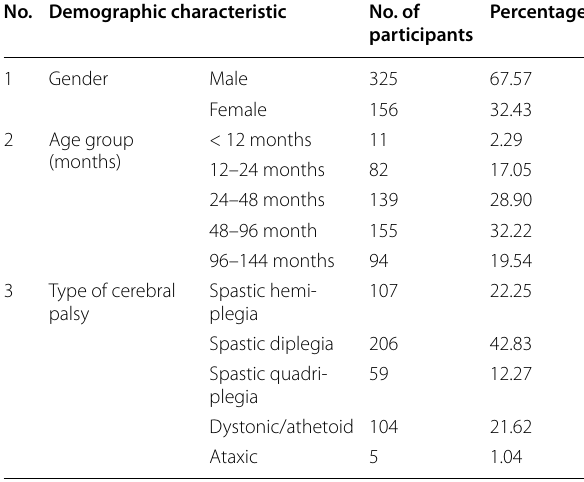
Table 3 Demographic characteristics of CP